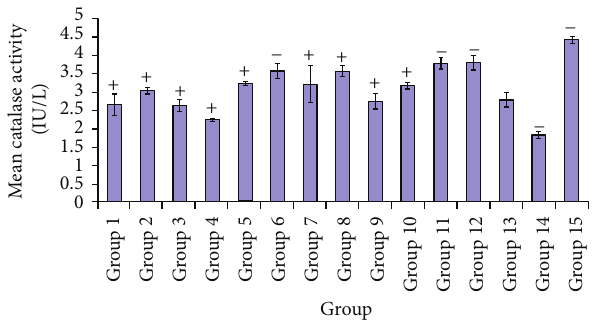
Figure 10: Comparative effects of some plants extracts on catalase level.